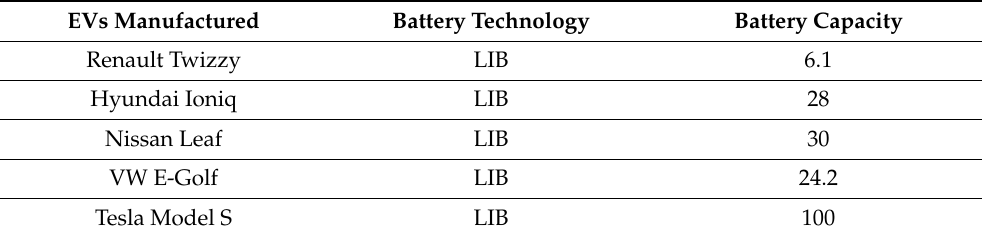
Table 1. Some EVs manufactured and the adopted ESS